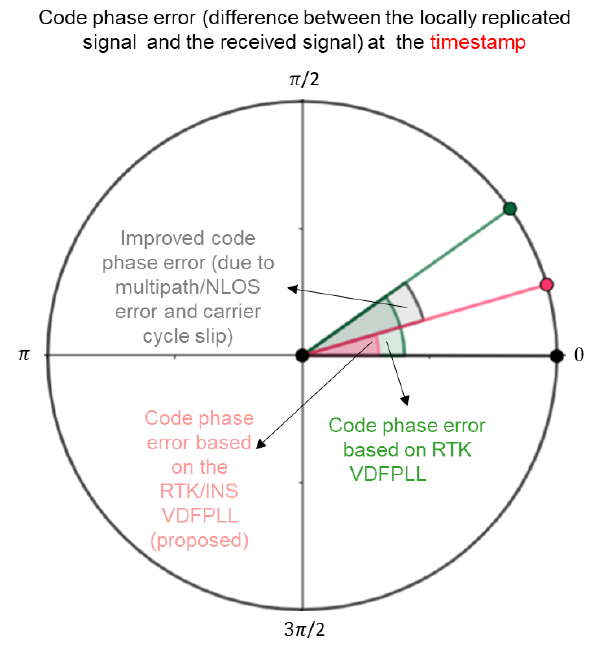
Figure 2. Comparison of the instantaneous code phase error at the timestamp (see the dashed red line in Figure 1) for extracting the instantaneous GNSS measurements (e.g., pseudoranges and carrier phases). It is worth mentioning that the code phase errors are exaggerated in this diagram by omitting random noise and raising the biased errors to show the differences in algorithms intuitively. The actual code phase errors usually do not exceed half of the early–late chip spacing. The numerical values in the figure correspond to the code